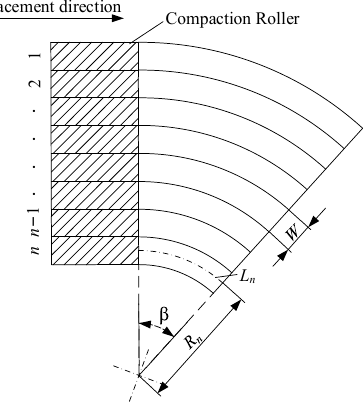
Figure 5. The multi-piece compaction roller. ( a ) The optimized compaction roller with 𝑛 individual roller components. ( b ) The multi-piece compaction roller for the experiment.